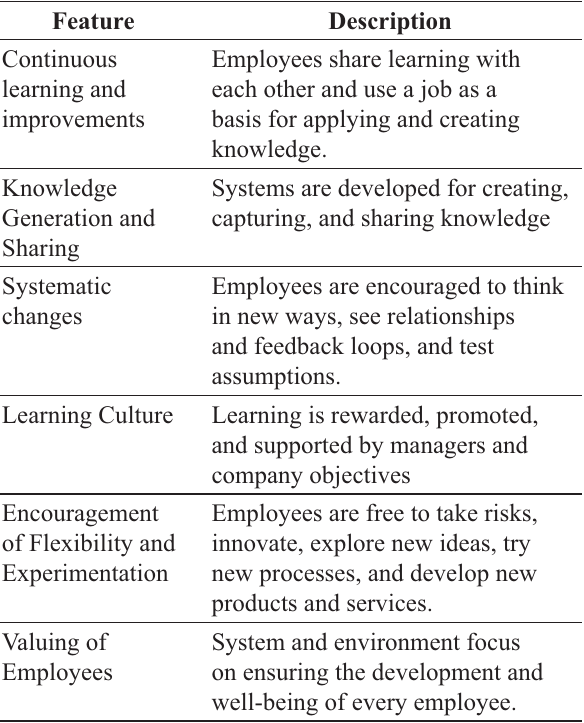
Table 1. Key features of a learning organization